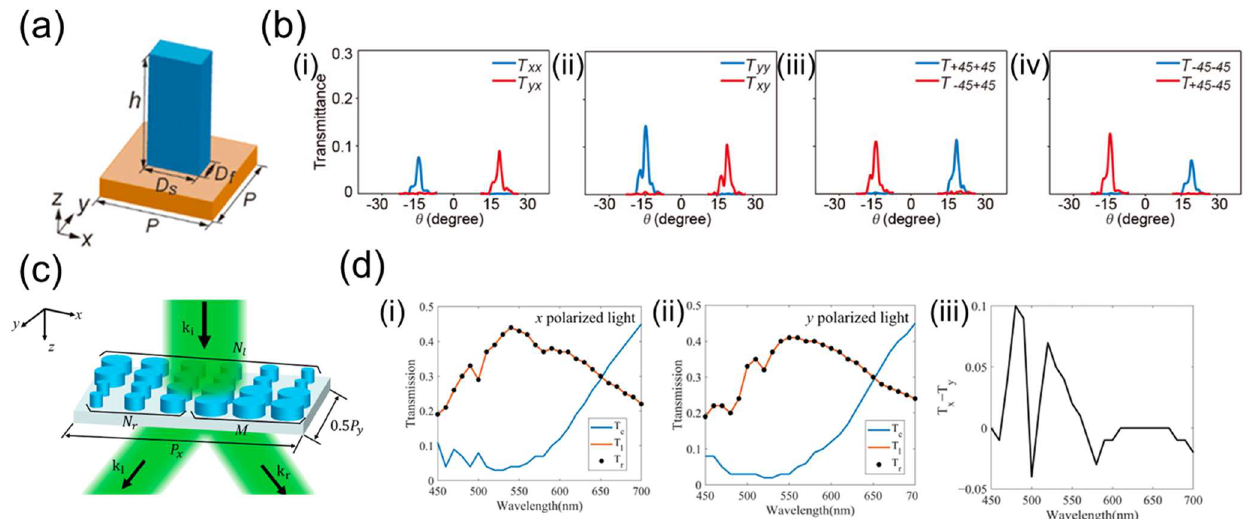
Figure 11. ( a ) Schematic diagram of the basic unit cell, which is a rectangular silicon pillar on a silicon substrate. Reprinted with permission from [112]. Copyright 2019 American Chemical Society. ( b ) Polarized transmittance distribution at 1 THz with incident light polarization angles x ( i ), y ( ii ), +45° ( iii ), and −45° ( iv ). Reprinted with permission from [112]. Copyright 2019 American Chem-